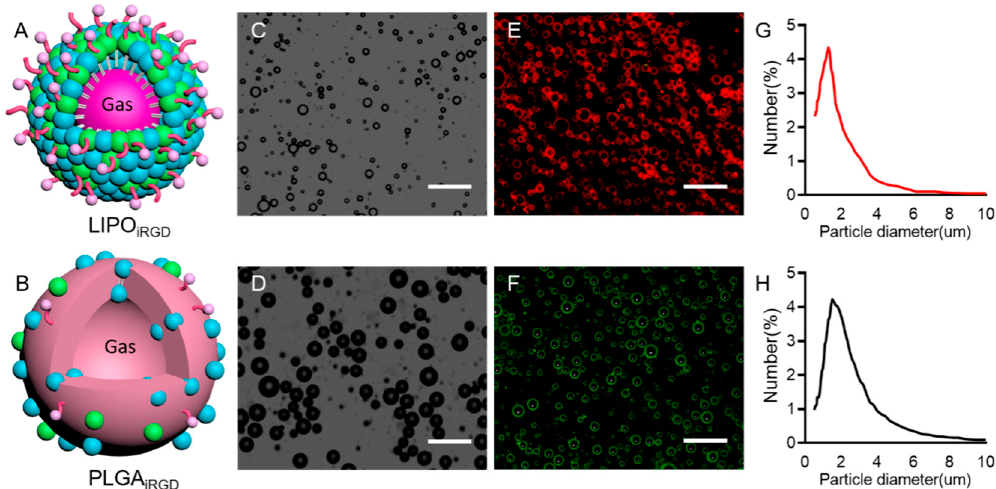
Figure 1. Schematic diagram of LIPO iRGD and PLGA iRGD and in vitro US imaging. Schematic diagrams of LIPO iRGD ( A ) and PLGA iRGD ( B ). Bright-filed photograph of LIPO iRGD ( C ) and PLGA iRGD ( D ). Fluorescent micrograph of DiI-labeled LIPO iRGD ( E ) and DiO-labeled PLGA iRGD ( F ). Average size and distribution of LIPO iRGD ( G ) and PLGA iRGD ( H ). Scale bar = 10 µm.